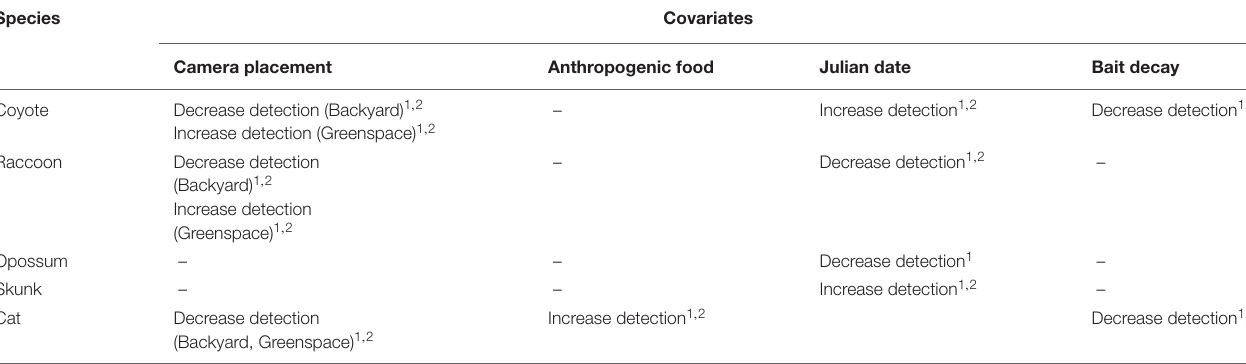
TABLE 2 | Summary of secondary covariates effects on mesopredator species.